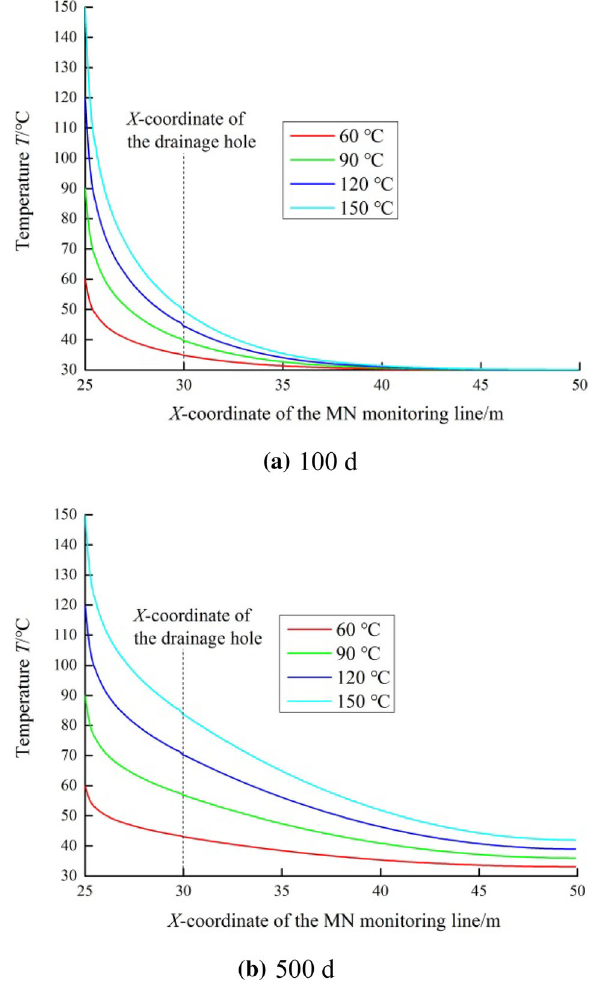
Fig. 6 Temperature distribution on the monitoring line MN with different injection temperatures after 100 d and 500 d injection times